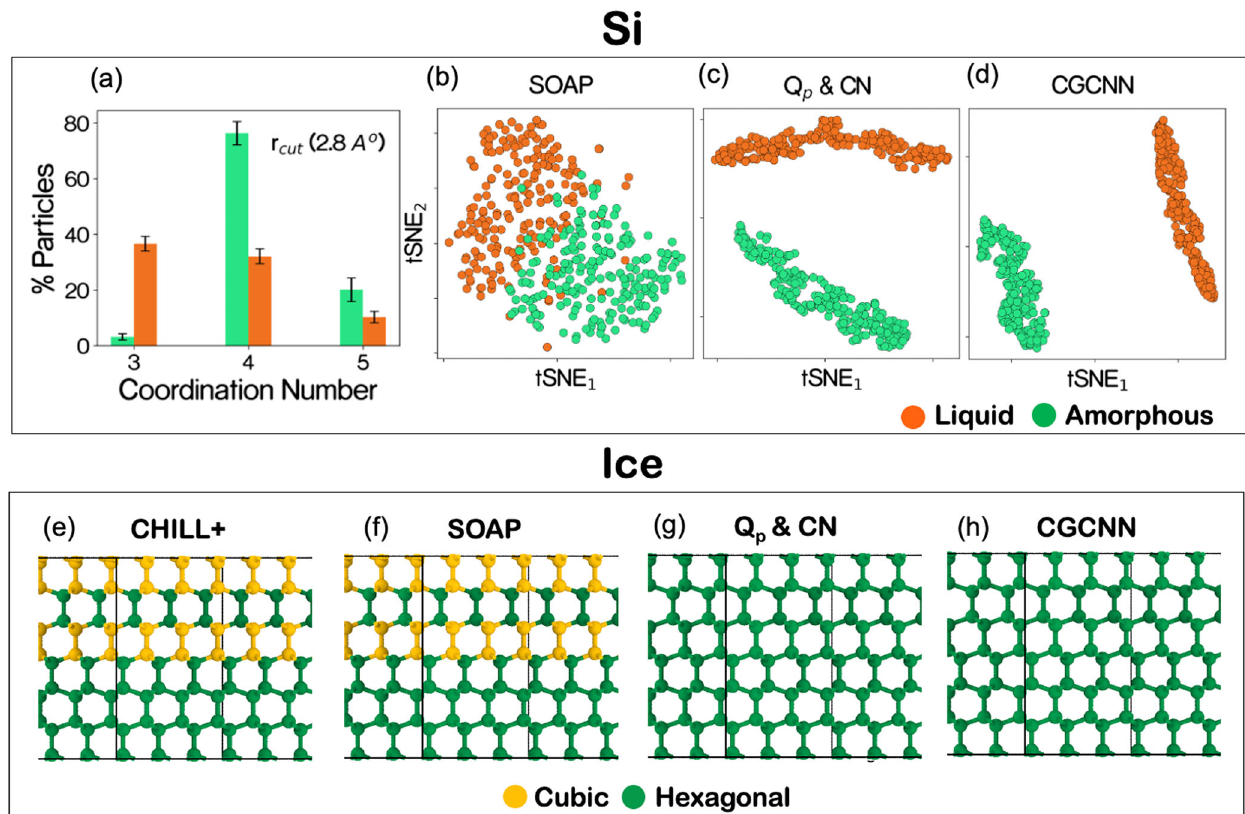
Fig. 1 Classi fi cation of silicon (Si) liquid and amorphous (glass) phases and atoms belonging to the hexagonal and cubic motifs in an ABABCB stacked ice. a Typical coordination number distribution of liquid and amorphous Si structures. b t-SNE plot of SOAP representation of the crystalline and amorphous Si phases in the test dataset. c t-SNE plot for bond-order parameters (Q 2 , Q 4 , Q 6 ) + CN (Coordination Number), feature representation. d t-SNE plot of embeddings of the test dataset obtained by training a classic CGCNN model. e classi fi cation of hexagonal and cubic stacked ice in an ABABCB stacked ice with CHILL + 48 algorithm. f classi fi cation using SOAP feature vector g by using order parameters (Q 2 , Q 4 , Q 6 ) + CN, and h using the trained CGCNN